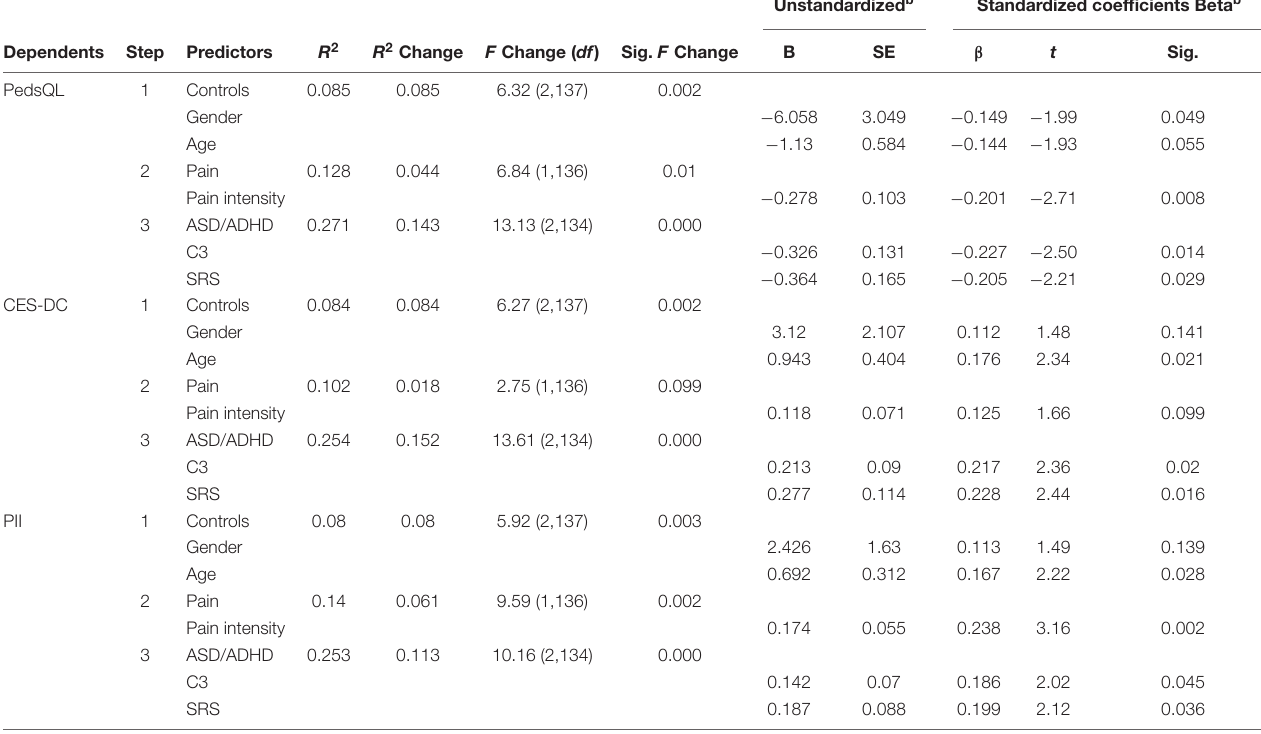
TABLE 3 | Hierarchical linear regression analyses examining the association between autistic traits (SRS) and ADHD symptoms (C3) on pain interference (PII), depression (CES-DC), and HRQoL (PedsQL) ( n = 146 a ), adjusted for gender, age, and pain intensity (LPQ).